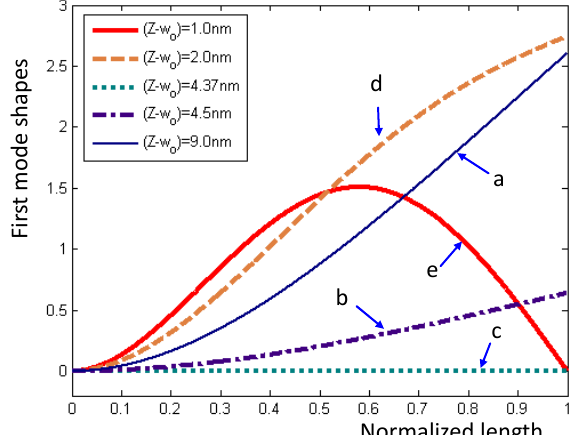
Figure 6. First mode shape functions for various tip-sample distances in Figure